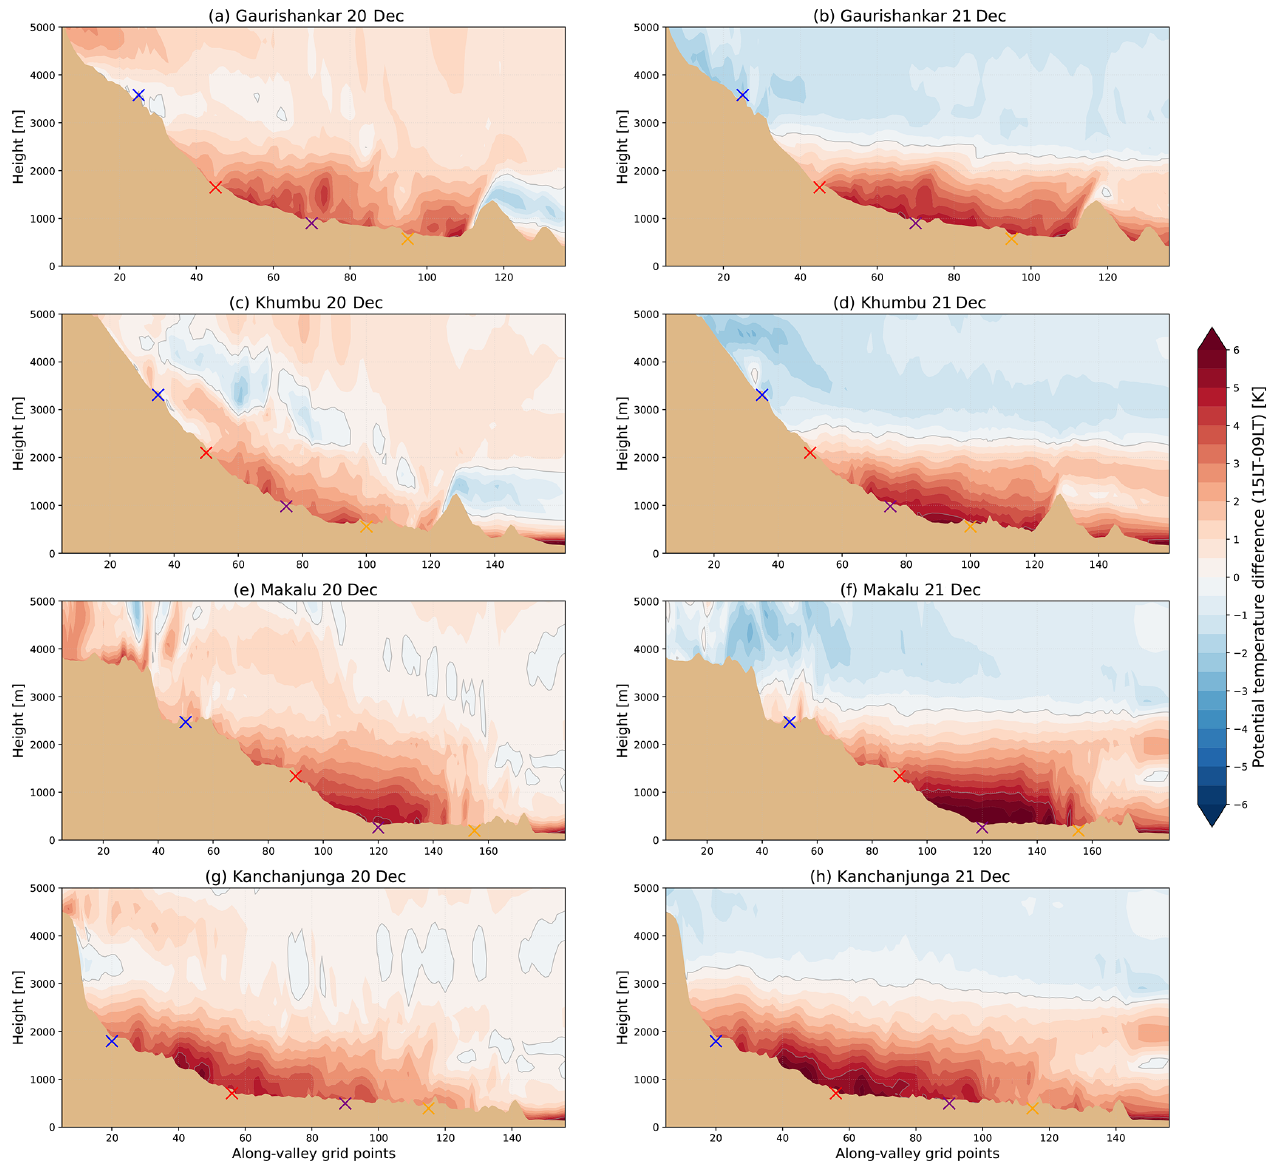
Figure 10. Vertical cross-section of potential temperature change above the valley centre lines (yellow lines in Fig. 2b) between 09:00 and 15:00LT on 20 December (a, c, e, g) and 21 December (b, d, f, h) . Positive values indicate higher potential temperatures at 15:00LT than at